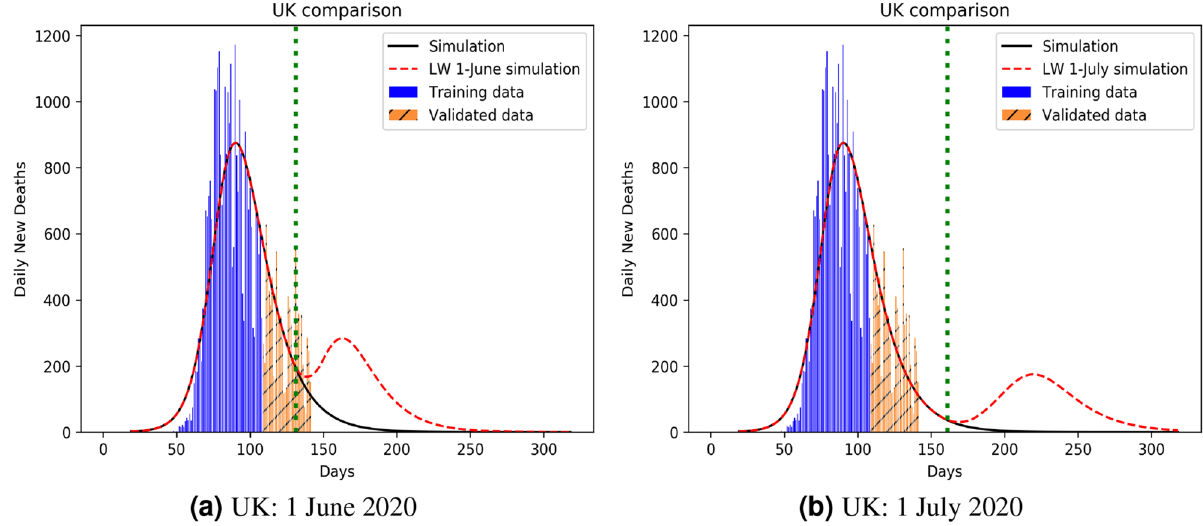
Figure 7. Infection kinetics compared for the UK for different lockdown withdrawal dates. Analysis is based on daily mortality statistics. The vertical dotted line represents lockdown withdrawal date t 0 in the function L ( t ) (see “Lockdown Dynamics” in “Methods” section). For the left and right panels t 0 is set to be 1 June 2020 and 1 July 2020, respectively. k = 20 and α = 2.4 are used in the function L ( t ) for simulating red dashed curves in both the plots. Here “0” marks 22 January